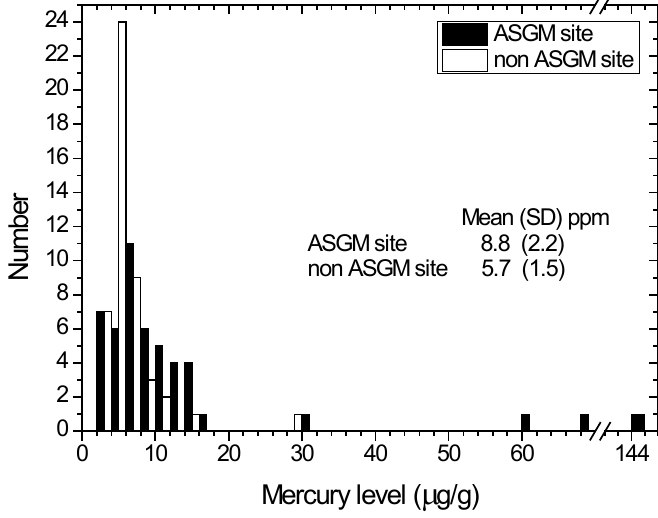
Figure 4. Distribution of the hair mercury among the total population according to their location from ASGM. Black and white bar indicate ASGM site inhabitants and non ASGM site inhabitants, respectively. Mean and standard deviation (SD) for both groups are given on the